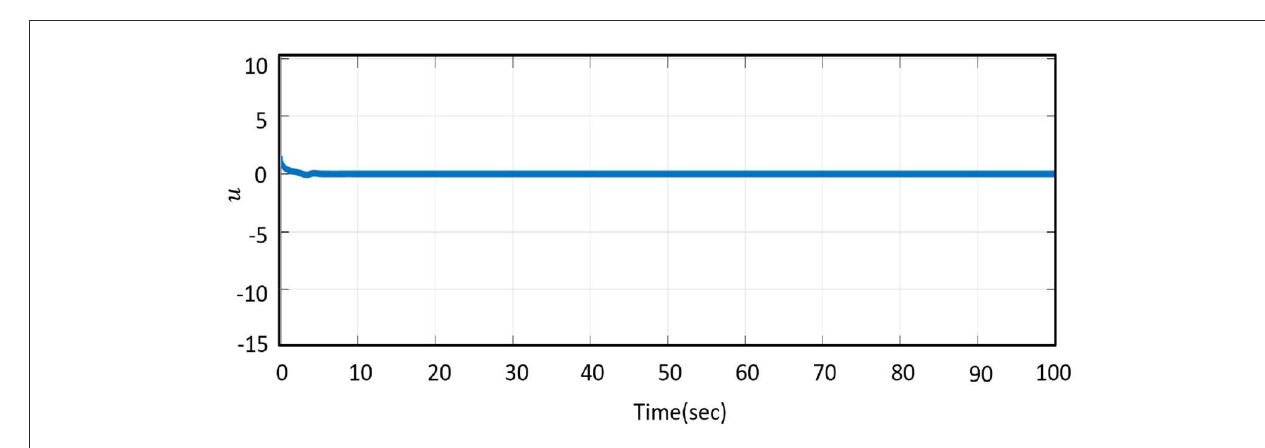
FIGURE13 Control effort u